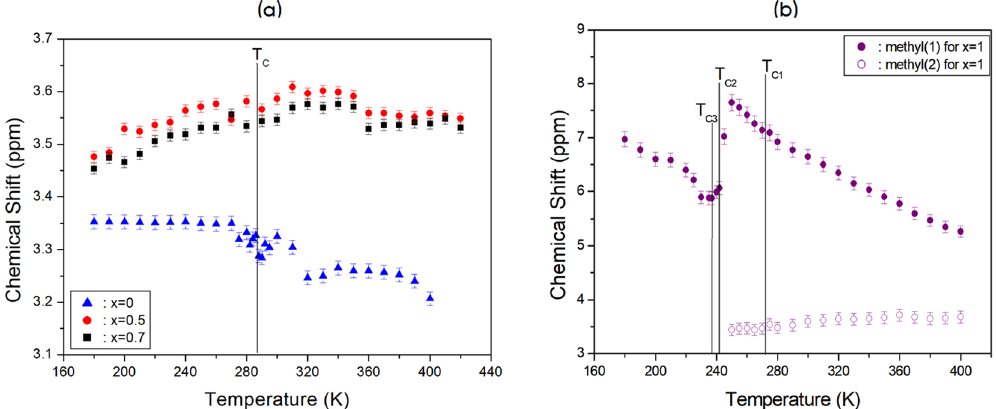
Figure 4. ( a ) Chemical shifts of the 1 H MAS NMR spectrum as a function of temperature for [N(CH 3 ) 4 ] 2 Zn 1- x Cu x Br 4 ( x = 0, 0.5, and 0.7). ( b ) Chemical shifts of the 1 H MAS NMR spectrum as a function of temperature for [N(CH